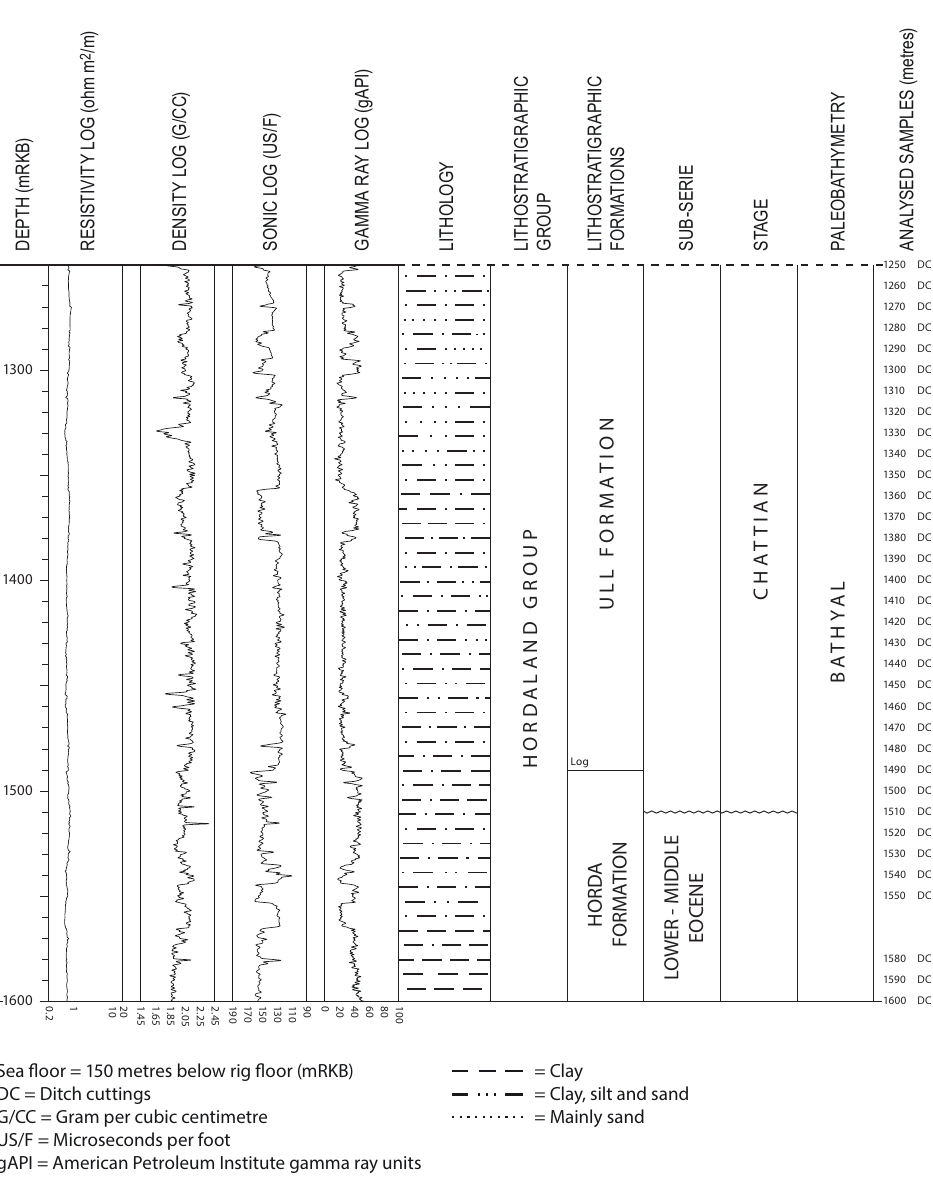
Figure 32. Well summary figure including resistivity log, density log, sonic log, gamma-ray log, lithology, litho- stratigraphic units, sub-series, stage, paleobathymetry and analysed samples for the lower part of the investigated sequence in well 34/10–17 (lower/middle Eocene to Chattian) including the lower part of the type section for the Ull Formation (modified after Eidvin et al.,